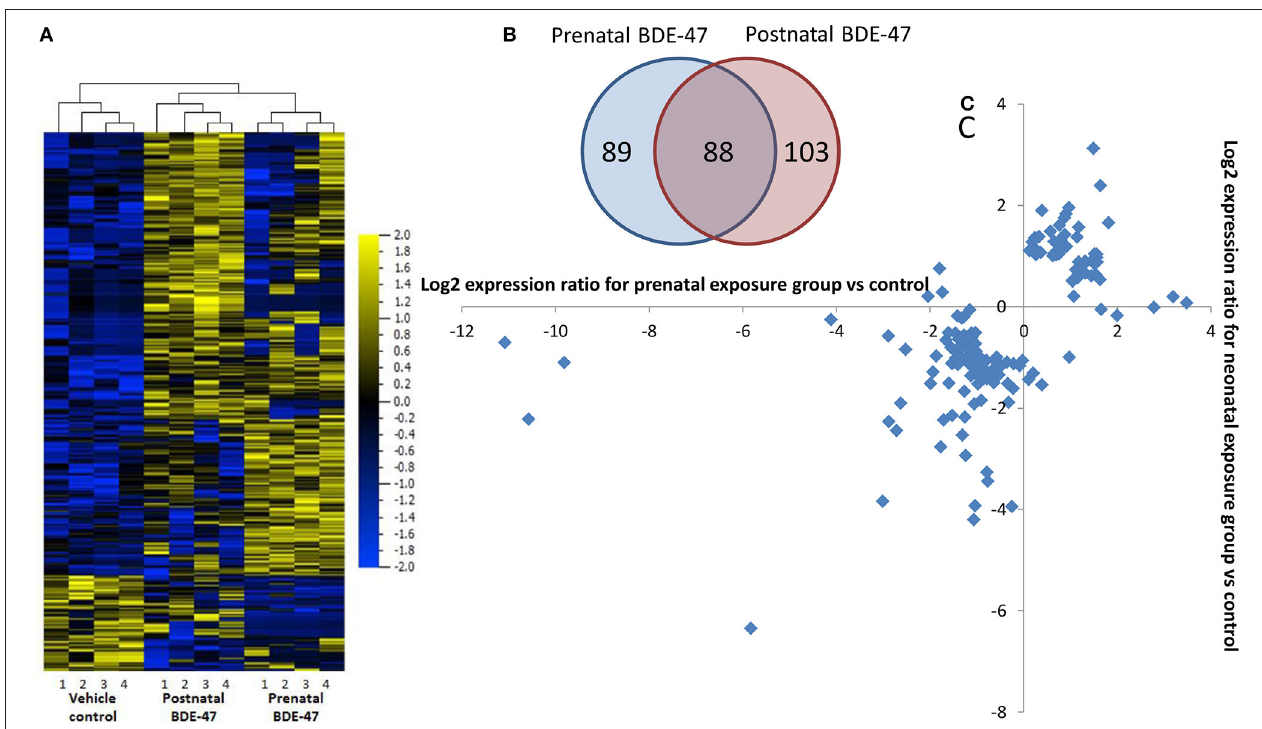
FIGURE 1 | Changes in liver gene expression in 10 months old mice are highly overlapping in groups exposed prenatally only and neonatally only to 1 mg/kg/body weight BDE-47: (A) –overlap in lists of significantly (FDR q ≤ 0.05) 2-fold differentially expressed genes; (B) –heat-map and unsupervised hierarchical clustering based on merged list 280 genes significantly (FDR q ≤ 0.05) 2-fold differentially expressed in pre- and/or postnatally exposed groups; (C) –changes in expression of non-overlapping genes (89 + 103 genes) in pre- and neonatal exposure groups, for majority of genes direction of change is the same in both groups.